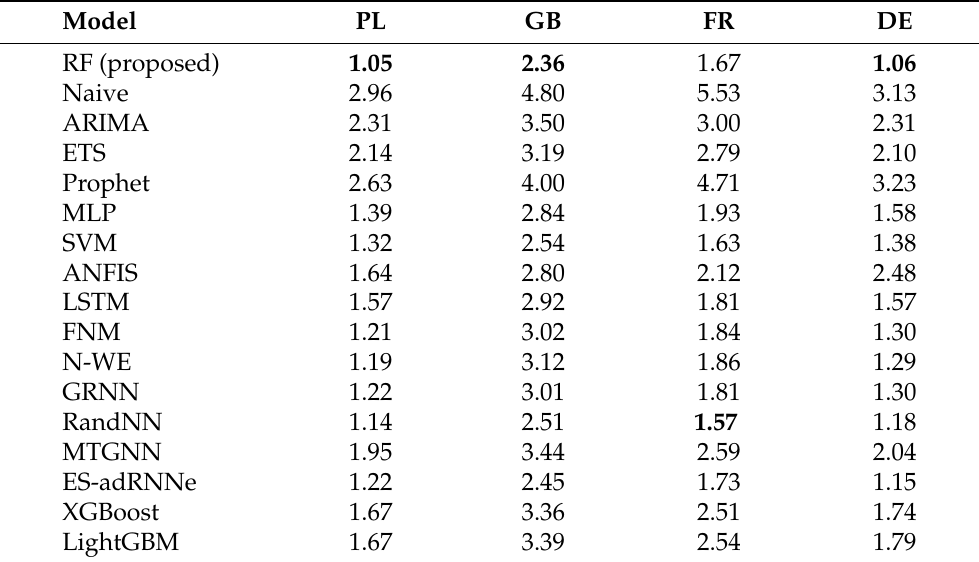
Table 5. MAPE comparison between RF and baseline models (lowest errors in